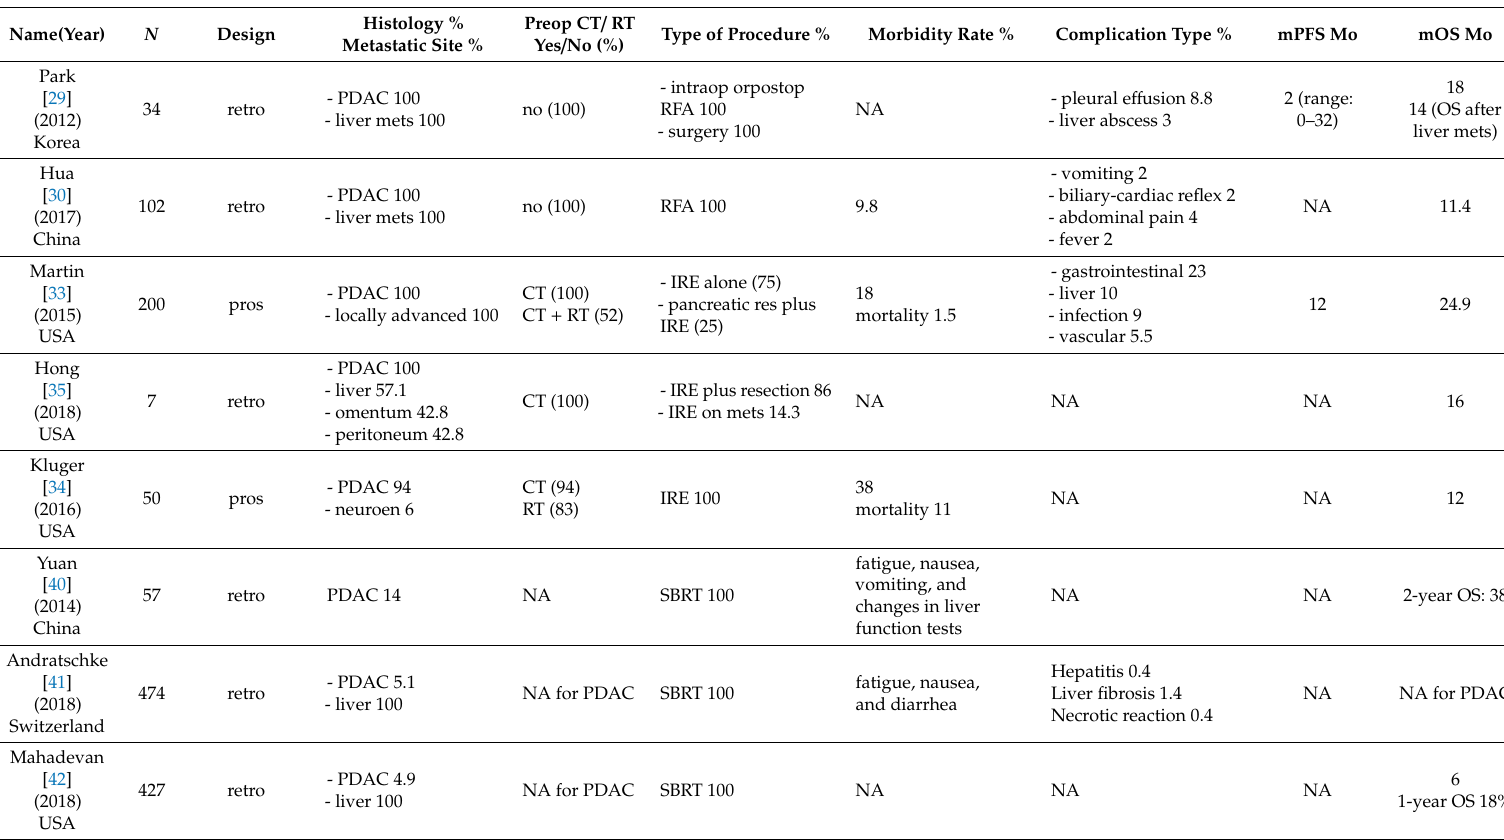
Table 2. Studies evaluating local ablative therapies for pancreatic ductal adenocarcinoma (PDAC) with